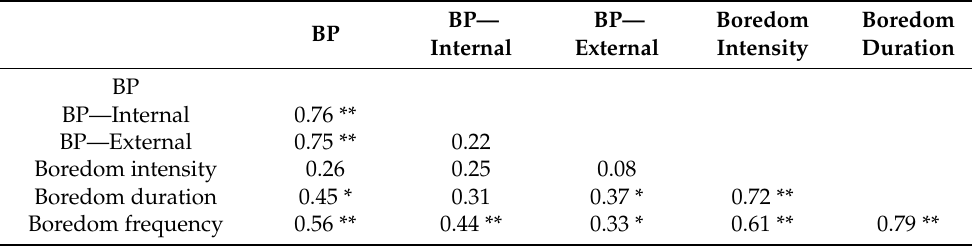
Table 1. Correlations among boredom proneness and boredom